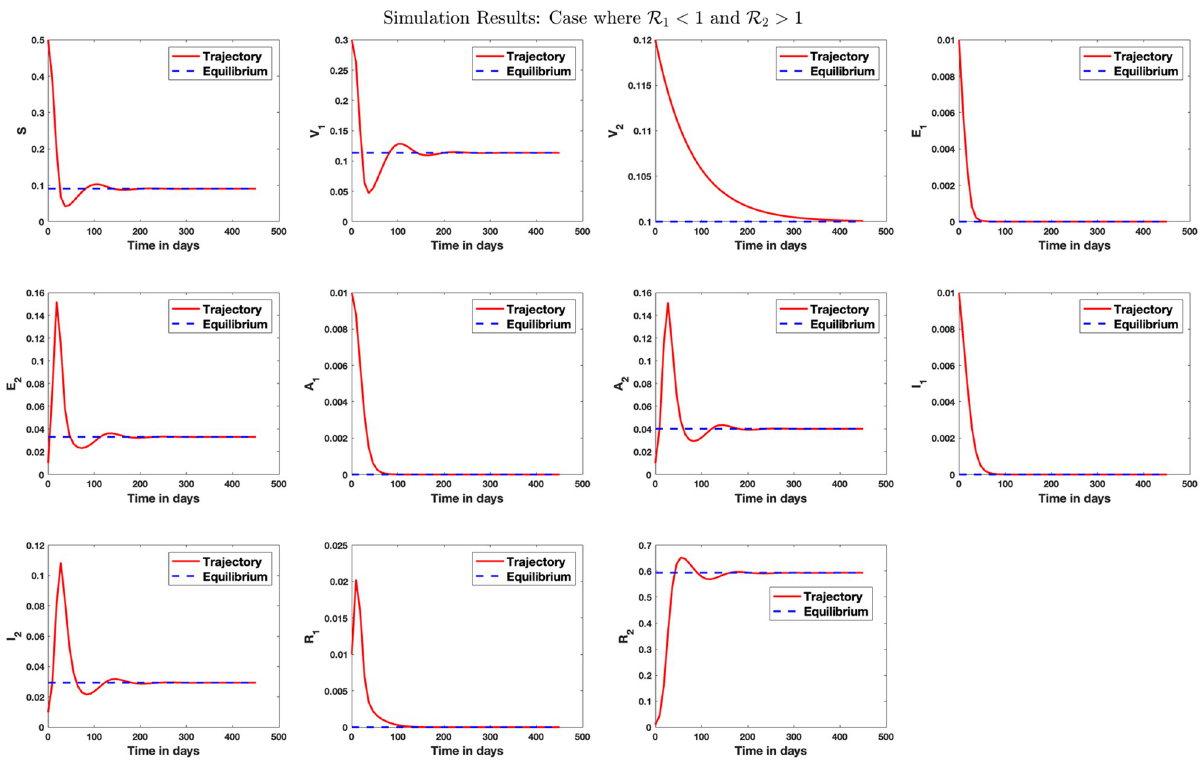
Fig 5. Stability analysis for strain 2 equilibrium. Case where R < 1 and R > 1 . In this case, we set β 1 = 0.18, β 2 = 0.9, γ 1 = 0.1, γ 2 = 0.4, μ = 1/80.3, 1 2 q 1 = 0.5, q 2 = 0.1, λ 1 = 1/5, λ 2 = 1/4, r 1 = 1/10.5, r 2 = 1/9, θ 1 = 0.09, θ 2 = 0.1. In this case, R 1 ¼ 0 : 47 and R 2 ¼ 4 : 41 so that R 0 ¼ 4 : 41 . The strain 2 equilibrium is obtained as E ¼ f 0 : 0907 ; 0 : 1134 ; 0 : 1000 ; 0 ; 0 : 0330 ;; 0 ; 0 : 0401 ; 0 ; 0 : 0294 ; 0 ; 0 : 5934 g . This vector shows proportions that each of the 2 population sizes S , V 1 , V 2 , E 1 , E 2 , A 1 , A 2 , I 1 , I 2 , R 1 , R 2 converge to on the long